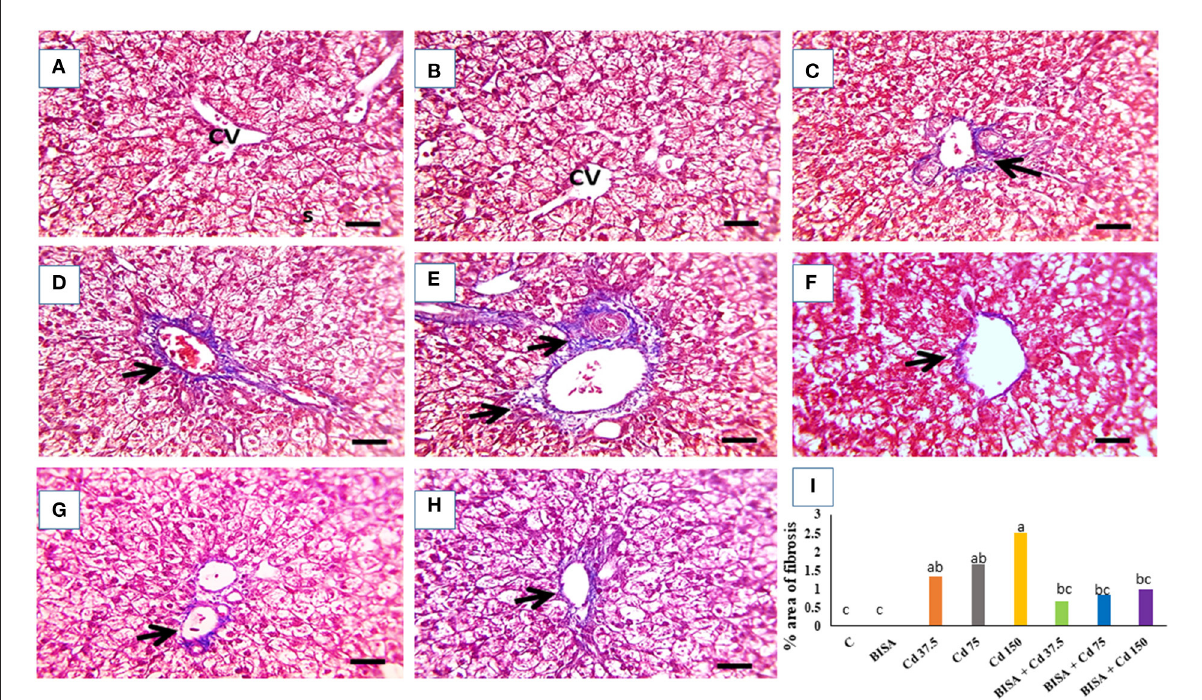
FIGURE3 The representative light photomicrographs of ducks’ hepatic section (stained with Masson’s trichrome, X400). (A) Represents the control group (C) and (B) is for the α -bisabolol (BISA) alone group; both groups show normal hepatocytes and central vein (CV) with no collagen deposition. (C–E) are for groups receiving CdCl 2 at 37.5, 75, and 150 mg/kg diet, respectively, revealing blue-stained collagen deposition in portal areas which increase with the increasing dose of CdCl 2 . (F–H) Represent BISA + Cd 37.5, BISA + Cd 75, and BISA + Cd 150 groups, respectively, and show remarkable reduction in blue color-stained collagen deposition, compared to the corresponding groups receiving CdCl 2 only. (I) Exhibits the percent of area of collagen deposition. Data are shown as mean ± SEM ( n = 6 ducks). Bars carrying different letters are significantly different from one another ( p < 0.05). Quantification of the percent of the area with fibrosis was conducted using Image J software (National Institutes of Health, Bethesda, MD, USA). Scale bar = 50 µ